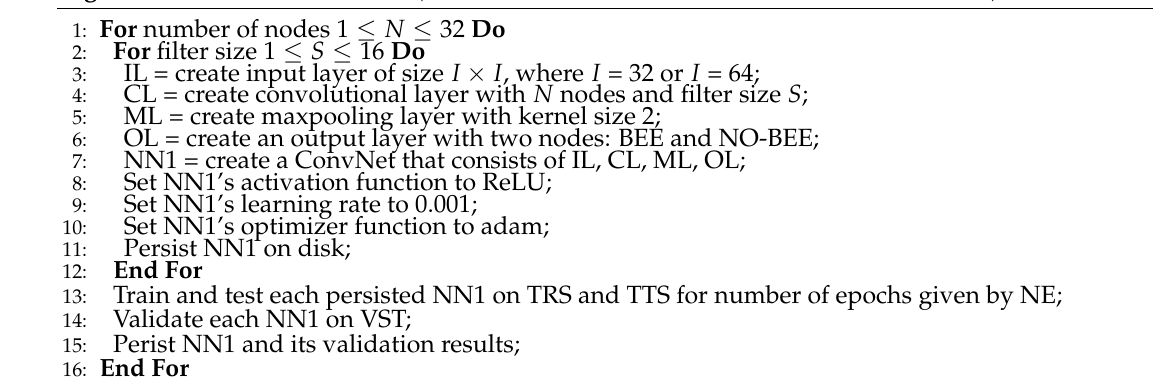
Algorithm 2 TrainGen1ConvNets (TrainSet TRS, TestSet TTS, ValidSet VST, and int